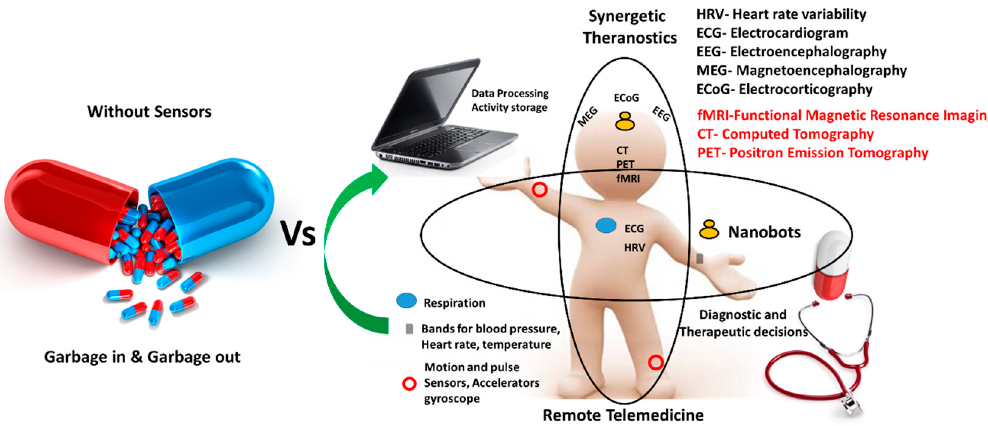
Figure 6. Generalized medication technique with respect to advanced synergistic approach in